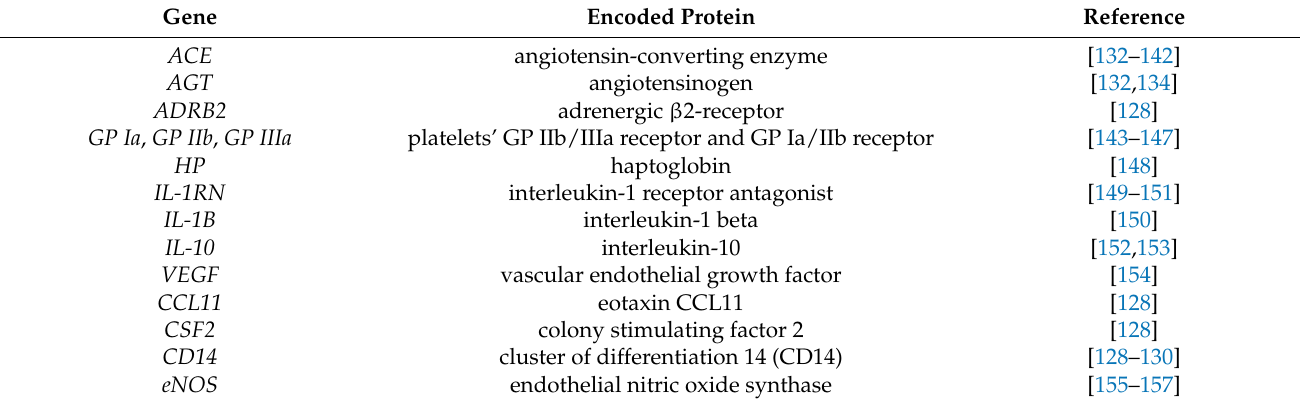
Table 5. Selected genes whose polymorphism has been investigated to be involved in the modification of the risk of ISR. Gene Encoded Protein